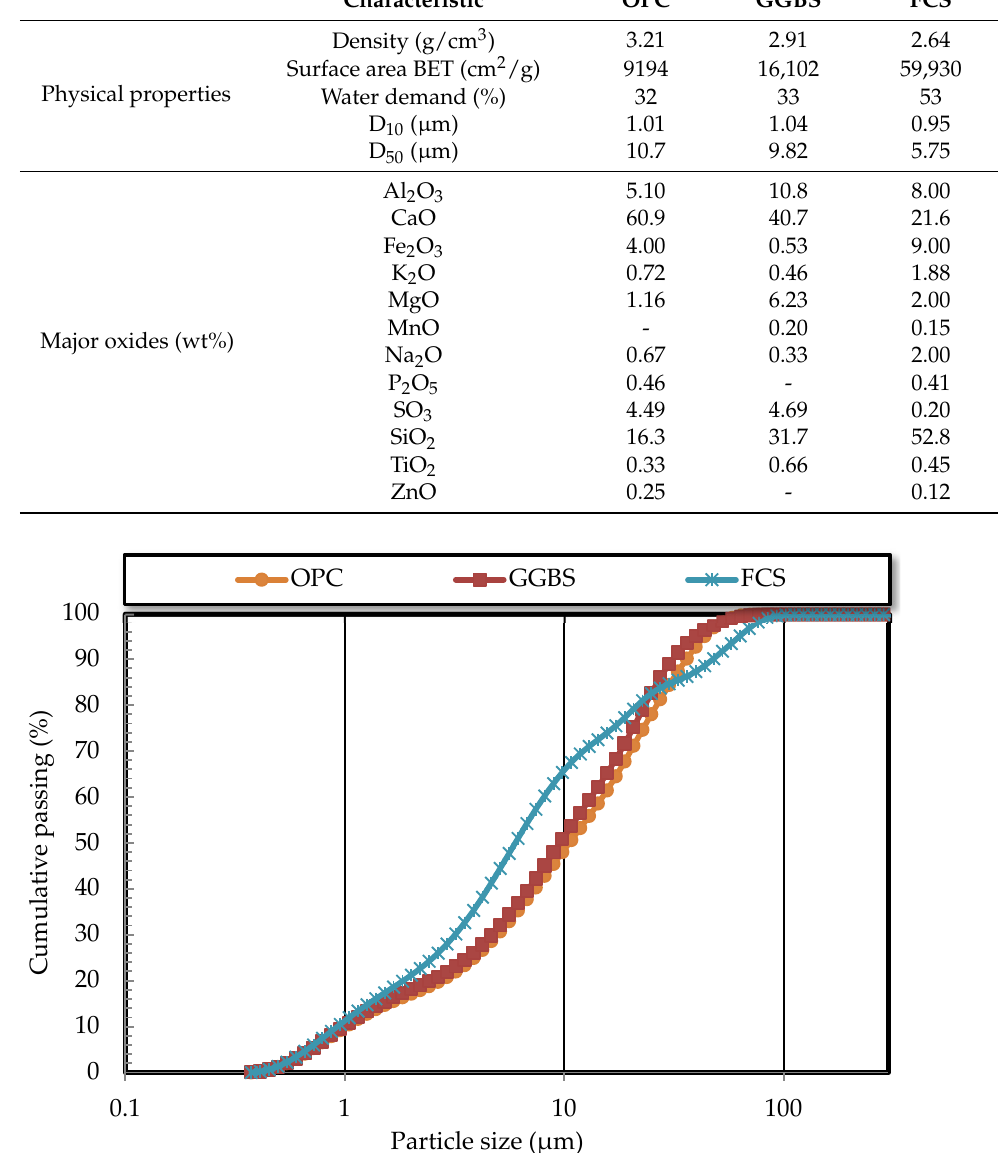
Table 1. Physicochemical characteristics of OPC, GGBS, and FCS.